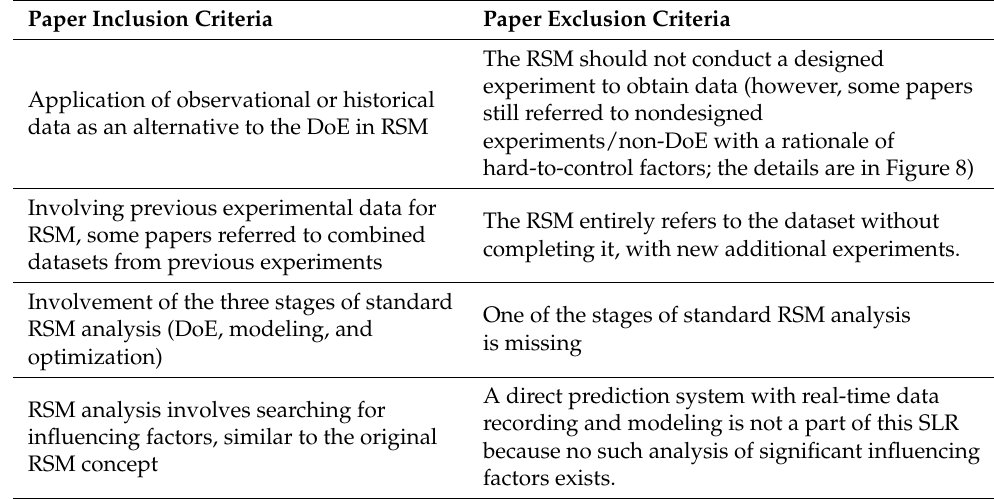
Table 1. Inclusion criteria for filtering papers.